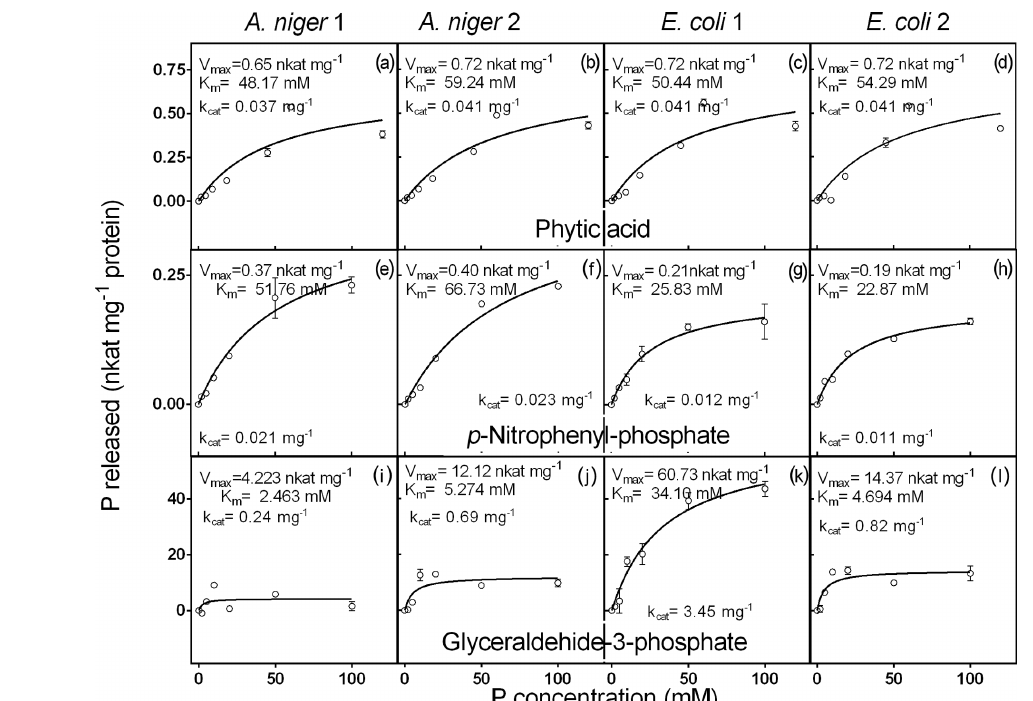
Figure 4. Kinetic parameters for phytic acid, p NP and G3Phosphate as substrates of purified phytases (two isolated from A. niger and two from E. coli ). The activity was determined at different concentrations of P (0 to 100mM) contained in phytic acid substrate. Each point represents the average of three observations minus the controls, as described in Sect. 2. Bars represent the standard error of the